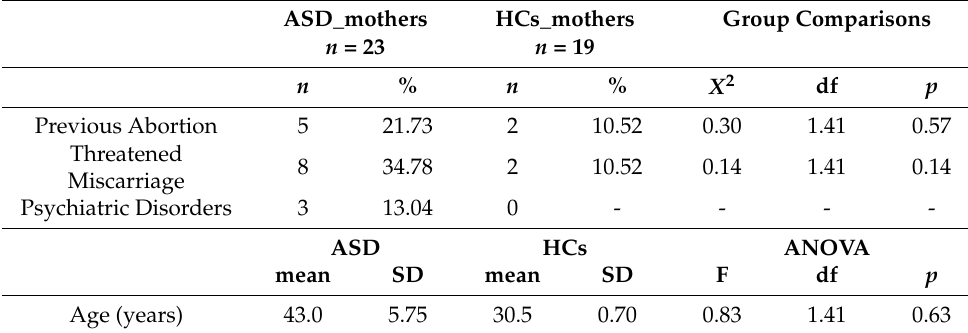
Table 4. Demographic and clinical characteristics of the mothers.